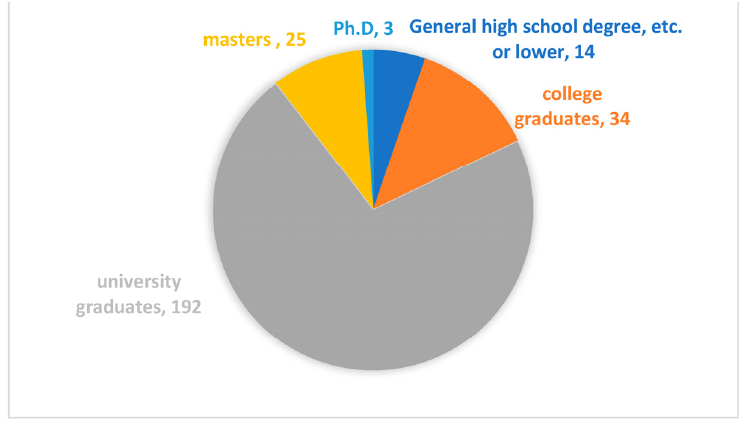
Figure 4. Distribution of educational qualifications (numbers in figure represent an actual number of test subjects in each group).